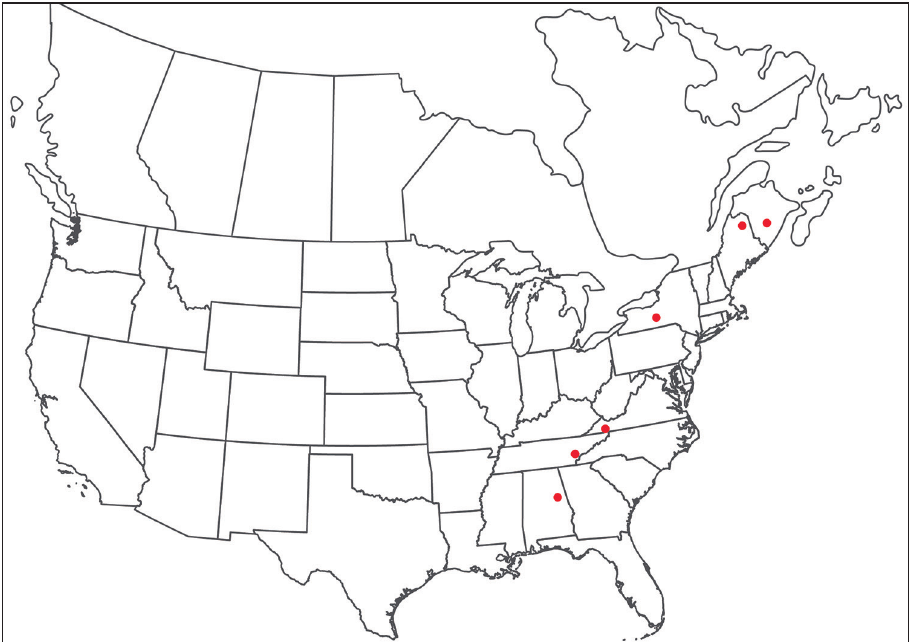
Figure 217. Torrenticola reduncarostra sp. n.